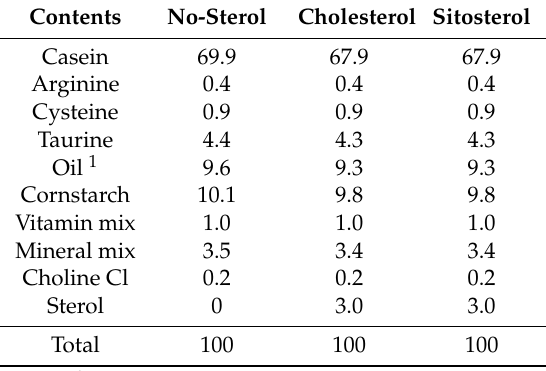
Table 1. Composition of three types of diet in